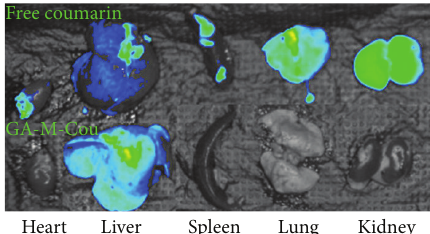
Figure 9: The tissue distribution of free coumarin and coumarin loaded GA-PEG-GA